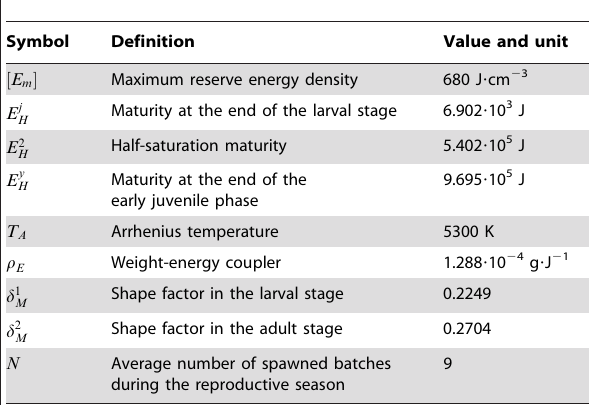
Table 6. List of symbols III: other parameters.